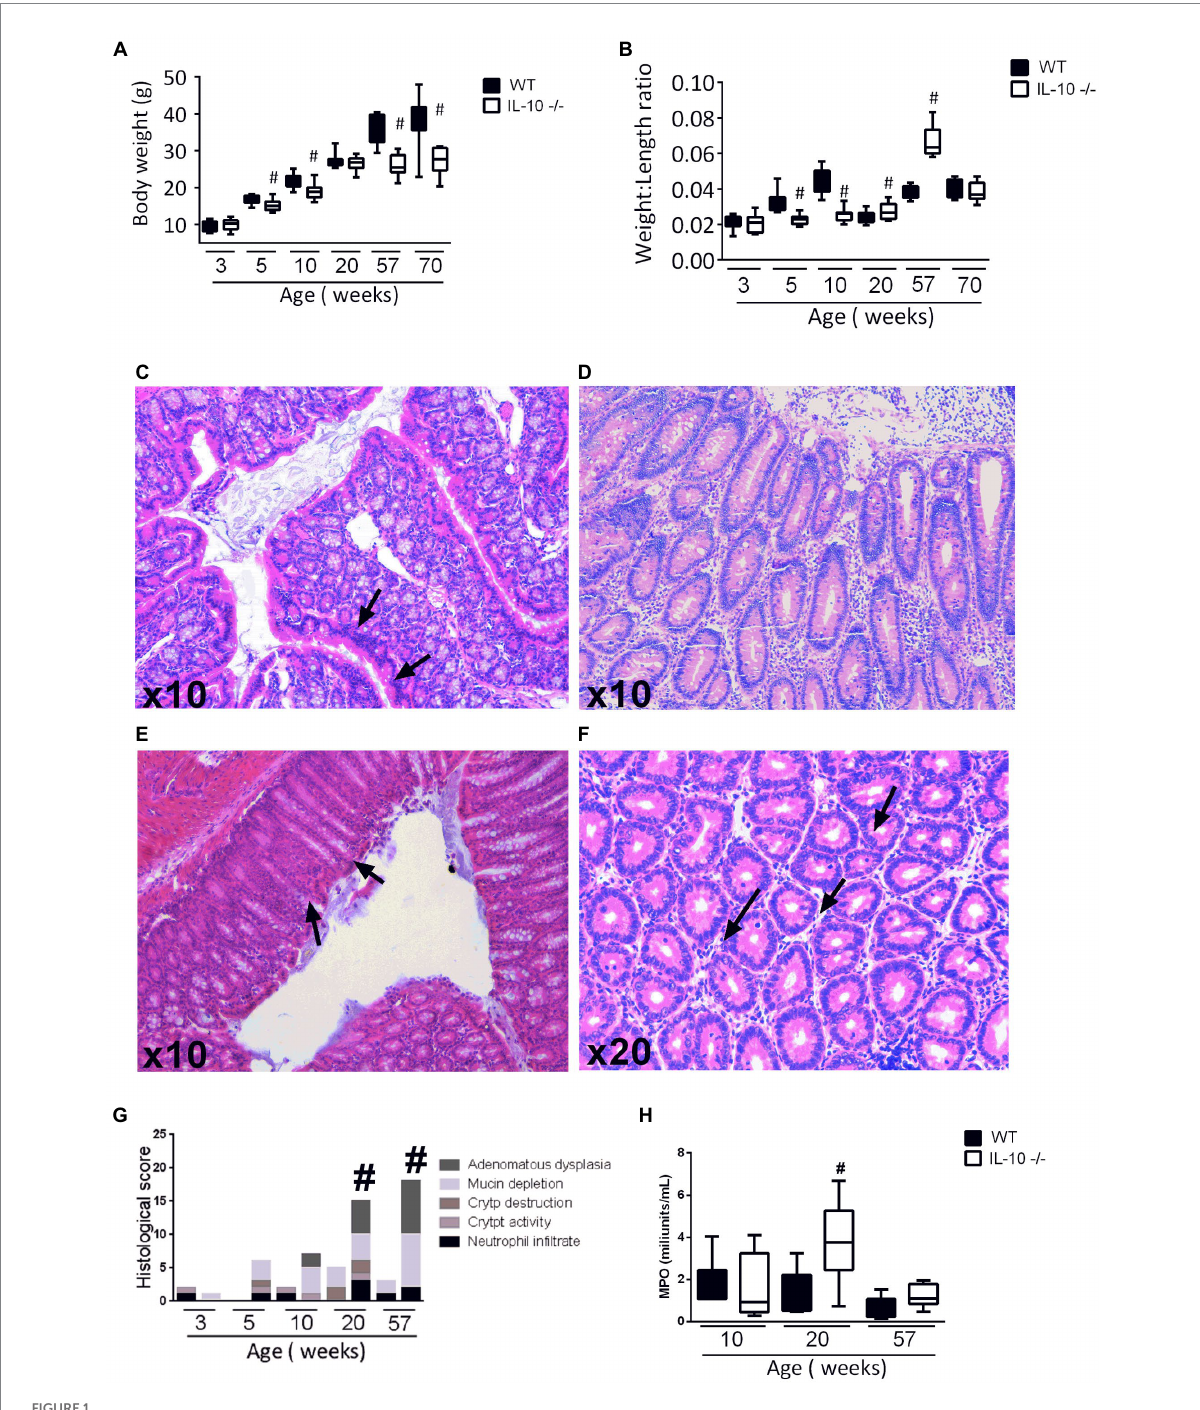
FIGURE 1 (A) Body weight after sacrifice (B) Weight to length ratio of the colon of both strains. (C–F) Hematoxylin eosin staining in 20-week-old IL-10- deficient mice. Representative images of: inflammatory infiltrate, epithelial stratification, focal erosion, and mucin depletion, respectively. (G) Comparison of histological scoring of both strains of all ages (5 animals for each strain and age group were used in this analysis). (H) Measurement of the Mieloperoxidase (MPO) enzyme activity by colorimetric reaction at 10, 20, and 57 weeks of age in both strains made in three independent replicates. In all graphs, C57Bl/6 wild type (WT) group was represented in black and IL-10 deficient mice (IL-10 − / − ) group in white. # p < 0.05 with respect to wild type